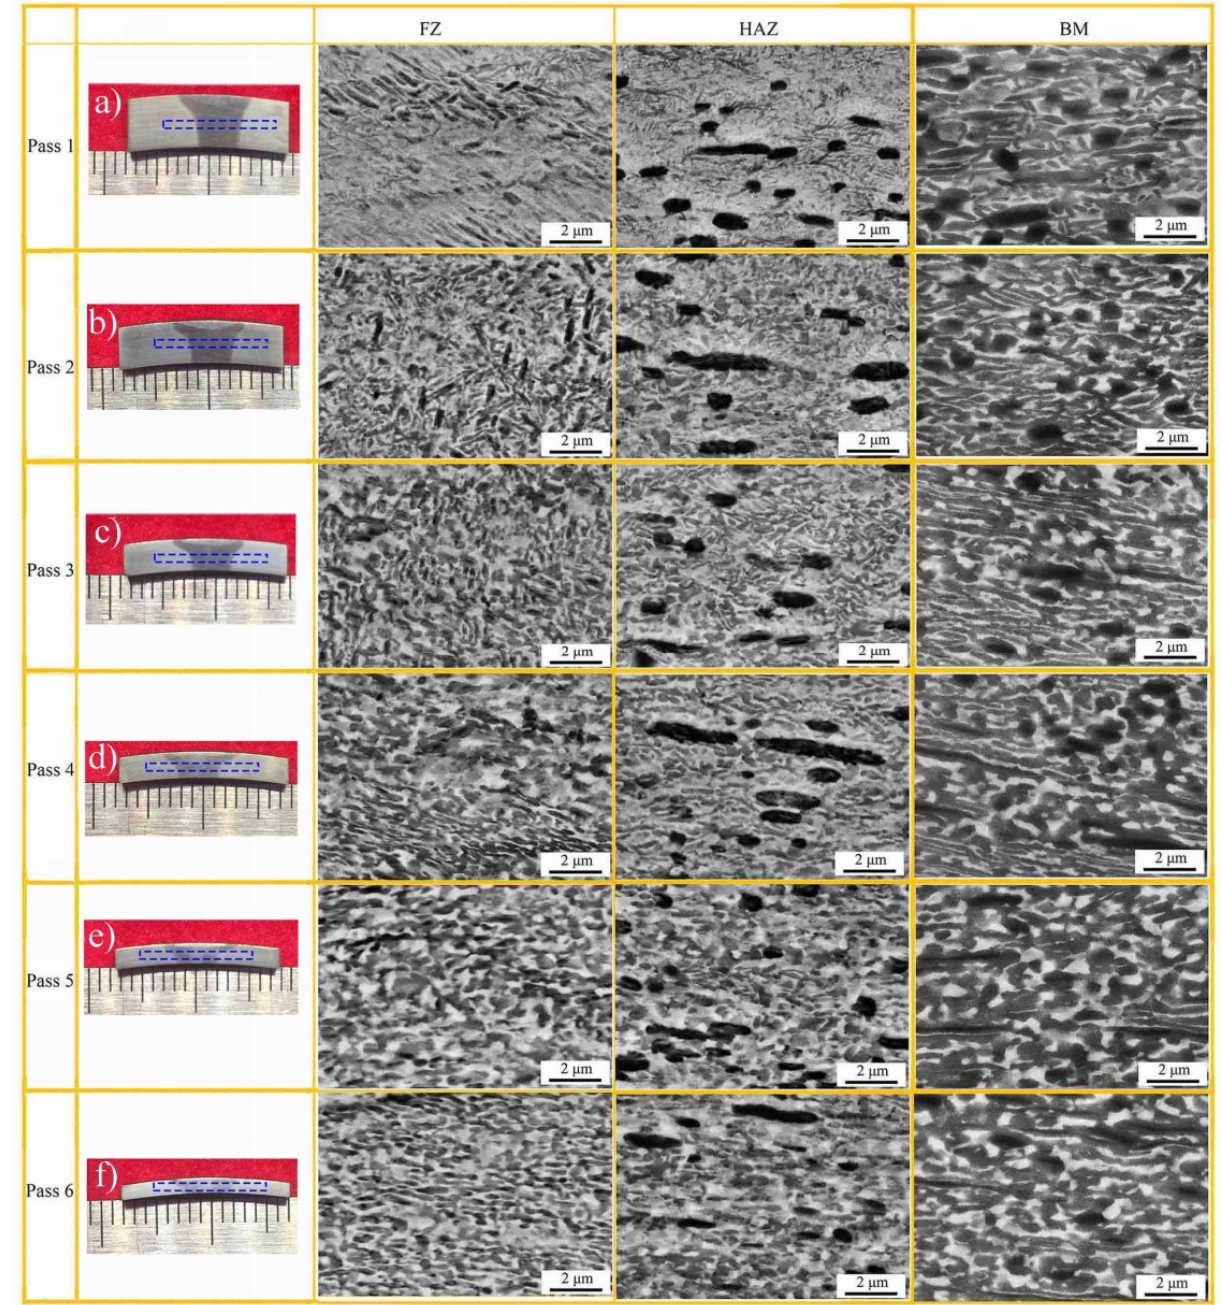
Figure 5. Microstructure evolution of EBW welded joint during 6-pass power spinning: ( a – f ) post- welded spun joints with different thinning ratios: 20%, 36%, 49%, 60%, 68% and 74%, Table 2. Area fraction of α 2 , O and B2 phase in the welded joints (%). (Measured by the Image-Pro Plus software).